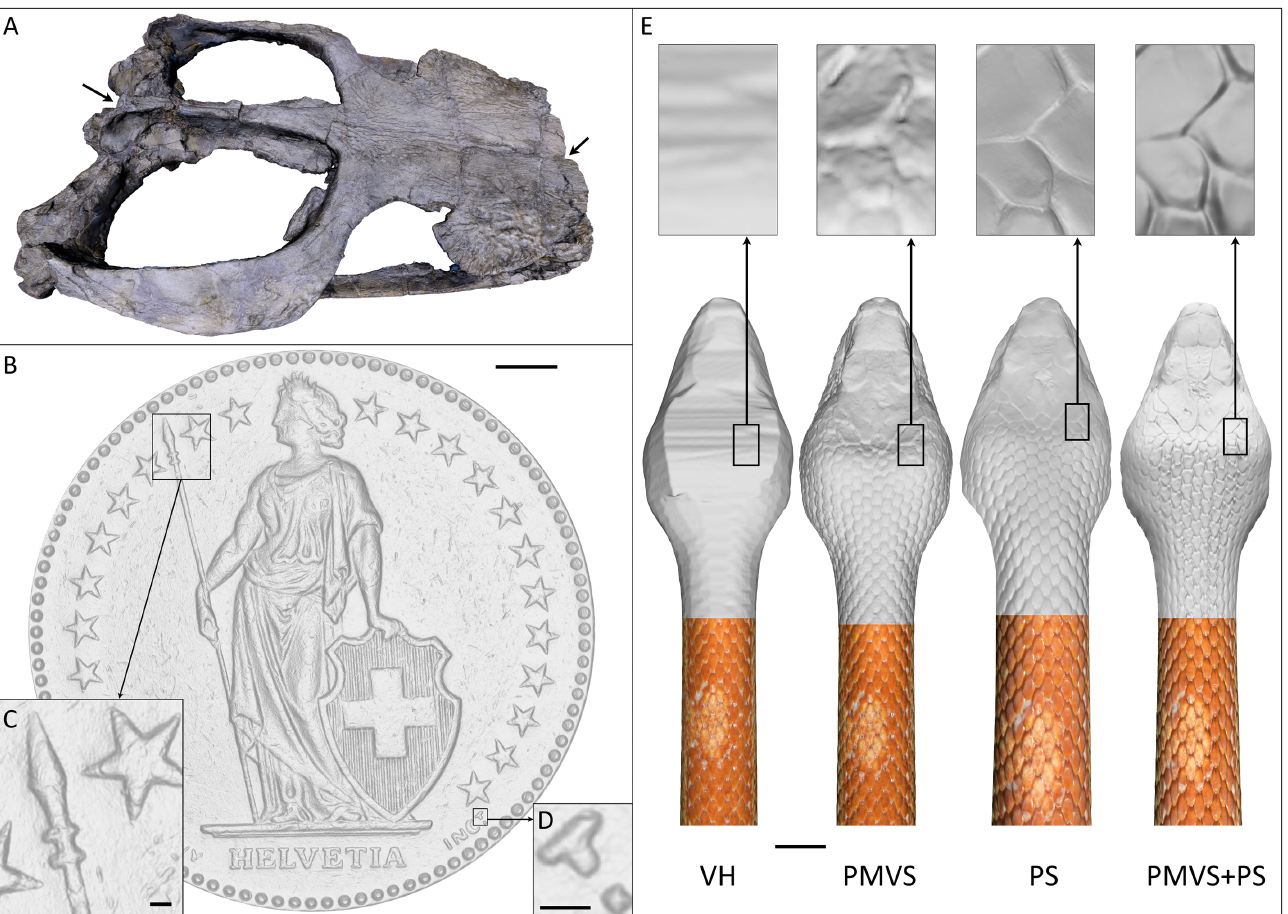
Fig 5. Multiple applications of R 2 OBBIE. A) PMVS reconstruction (~24 hours of reconstruction time) of a 155 – 161 million-year-old marine crocodylian fossil ( Metriorhynchus superciliosus ; specimen PIMUZ A/III 14 from the Paläontologisches Institut und Museum, Universität Zürich, Switzerland). Multiple scans in the ‘ static support ’ and ‘ turn-table ’ configurations were combined for a total of 746 pictures; linear distance between the two arrows = 21.4cm. B) Geometry of a 0.5 Swiss-franc coin scanned in the ‘ static support ’ configuration (30 pictures, ~20 seconds of scanning time) and reconstructed with PS (~30 minutes of reconstruction time); Scale bar: 2mm. C) and D) Details of B; Scale bars: 200 μ m. E) Corn snake ( Pantherophis guttatus ) geometry (and colour texture on bottom half of the mesh) scanned in the ‘ hanging anaesthetised snake ’ configuration (100 SFM pictures + 30 PS pictures, ~7 minutes of scanning time) and reconstructed with visual hull (VH, ~2 hours of reconstruction time), structure-from-motion (PMVS, ~6 hours of reconstruction time), photometric stereo (PS, ~15 minutes of reconstruction time), and the hybrid mode (PMVS + PS, ~7 hours of total reconstruction time, i . e ., including the PMVS and PS reconstruction times and the combination step). Scale bar: 10 mm. Insets: zoom on